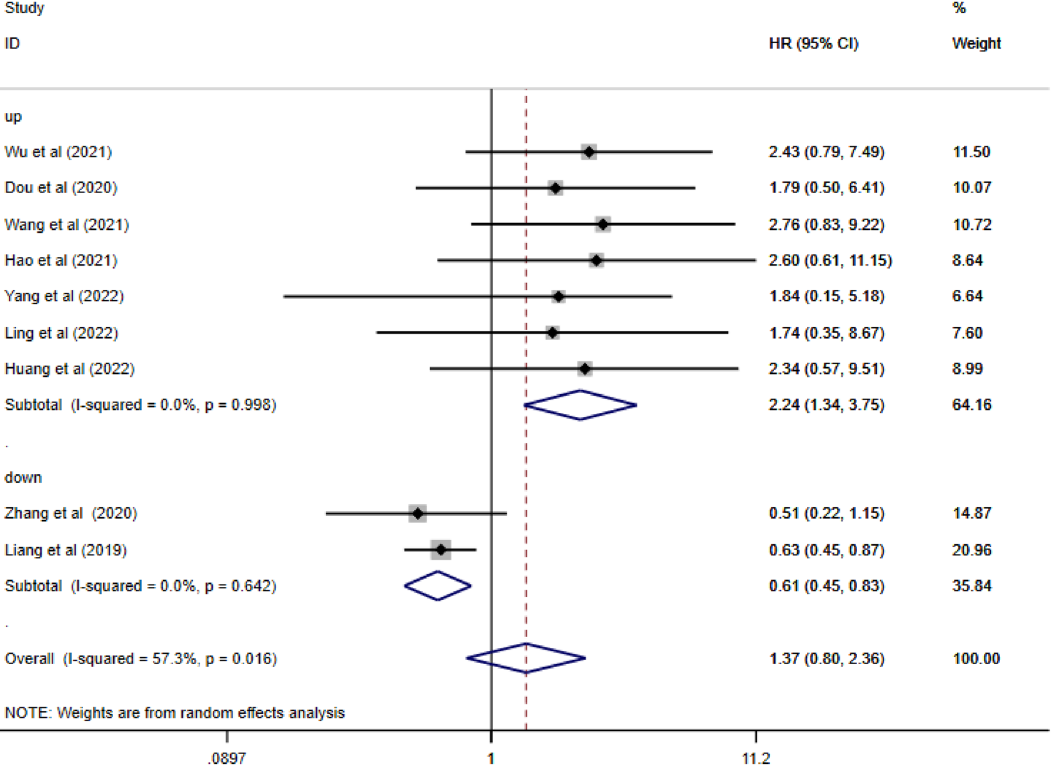
Figure 2. Pooled HRs for the overall survival of patients in the included studies.